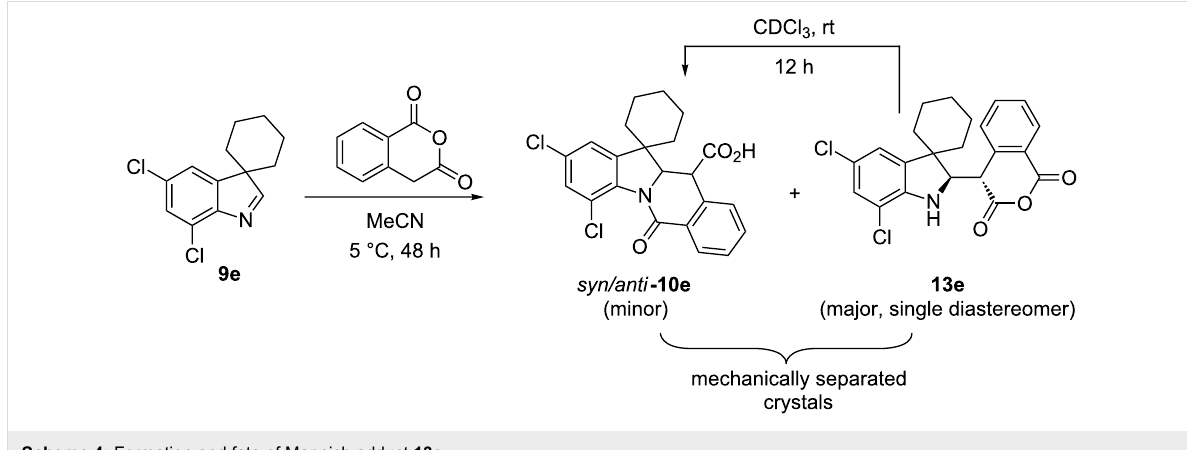
Scheme 4: Formation and fate of Mannich adduct 13e .